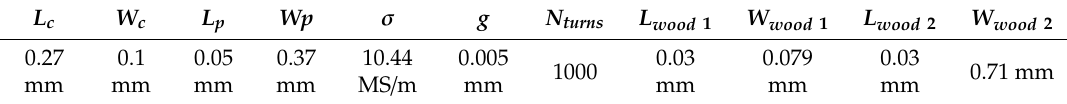
Table 2. Simulation parameters of the magnetic circuit in